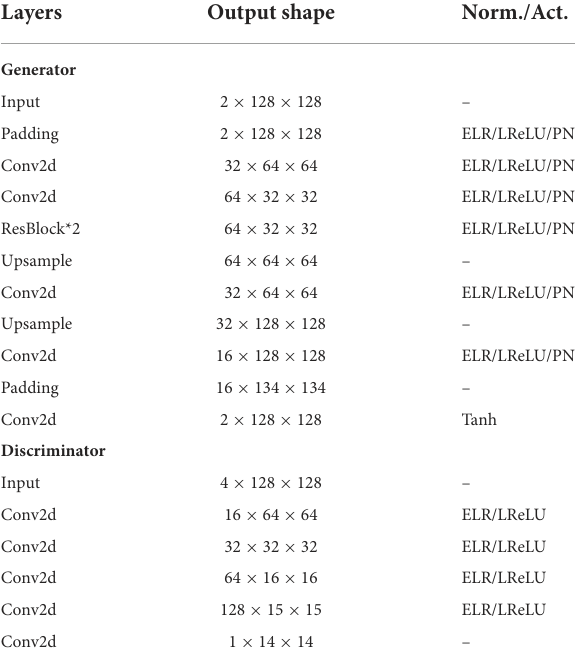
TABLE 1 Architectures of the proposed generator and discriminator. Layers Output shape